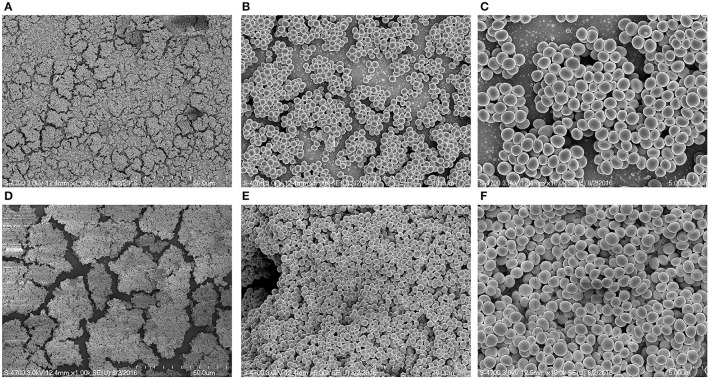
Scanning electron microscopic (SEM) image of methicillin-resistant Staphylococcus aureus (MRSA) biofilms grown with and without HQNO. Images (A–C) are representative SEM images of control biofilms (DMSO). (D–F) Representative SEM images of biofilm growth with 20 μg/ml HQNO. Scale bar = 5, 10, 50 μm.